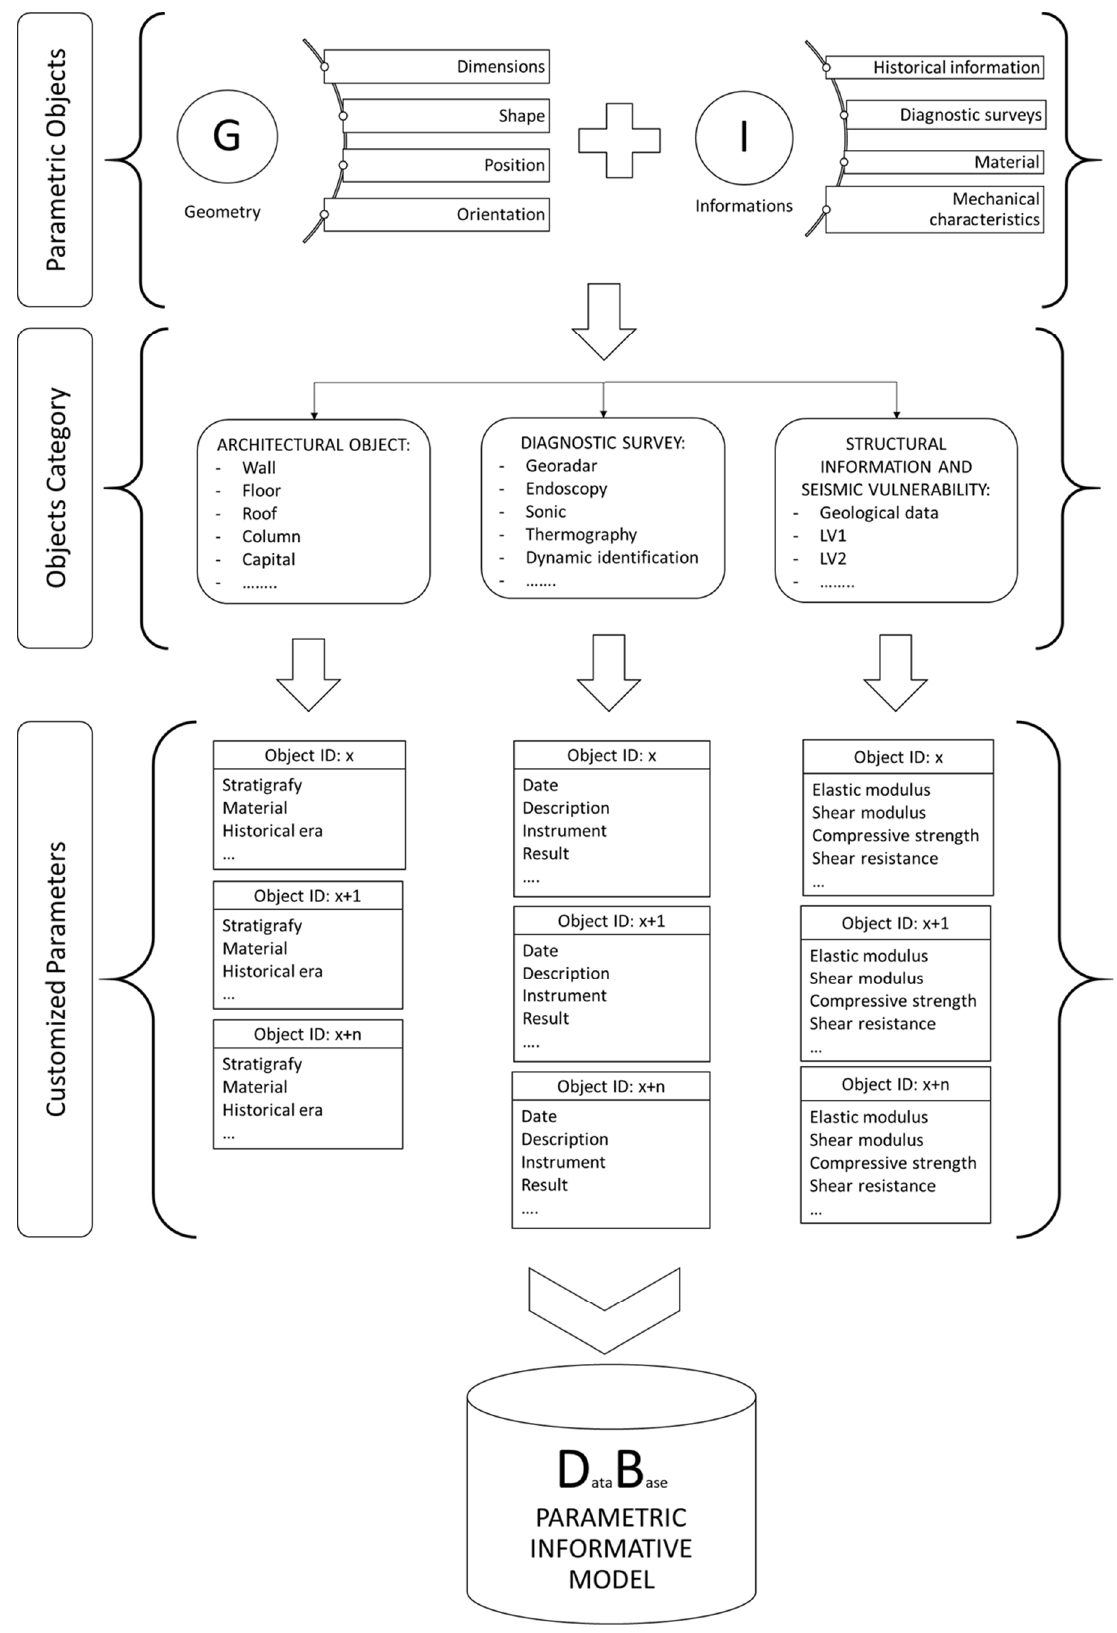
Figure 2. The structure of the BIM model.